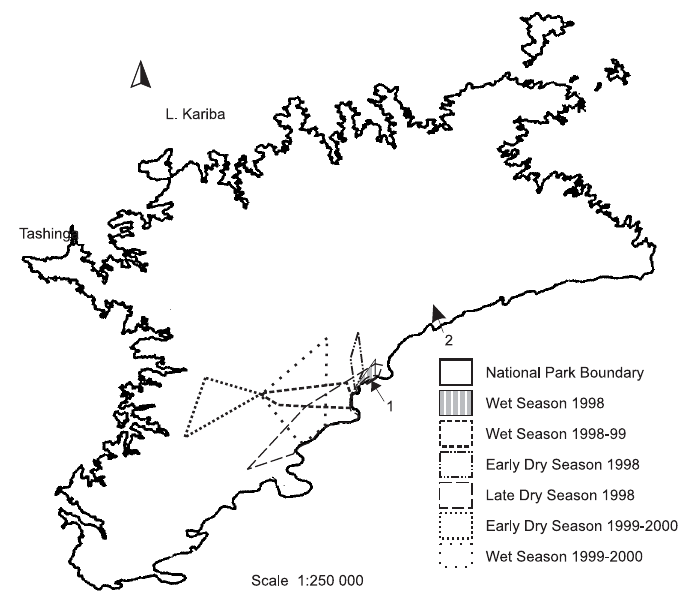
Park.Fig. 1. Map of Matusadona National Park (MNP) showing seasonal ranges of a hand-raised rhino, ‘Chewore’. 1. First release site (Mhukadzapera River) 2. Second release site (Nyamoni